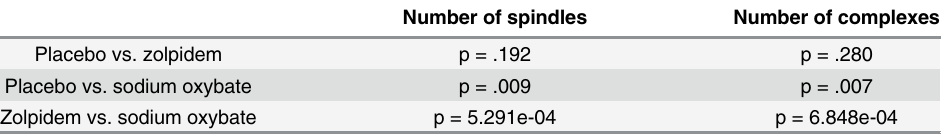
Table 2. t-test pair comparison between drug conditions on number of spindles and spindle/SO complexes. Number of spindles Number of complexes Placebo vs. zolpidem p = .192 p = .280 Placebo vs. sodium oxybate p = .009 p = .007 Zolpidem vs. sodium oxybate p = 5.291e-04 p = 6.848e-04 Repeated-measures ANOVA on numbers of spindles: p < 001. Repeated-measures ANOVA on numbers of spindle/SO complexes: p <